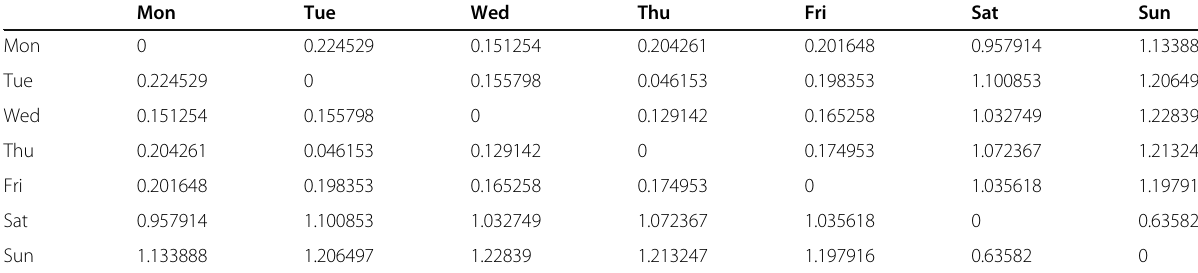
Table 2 DTW distance between normalized timelines of different days in a week Mon Tue Wed Thu Fri Sat